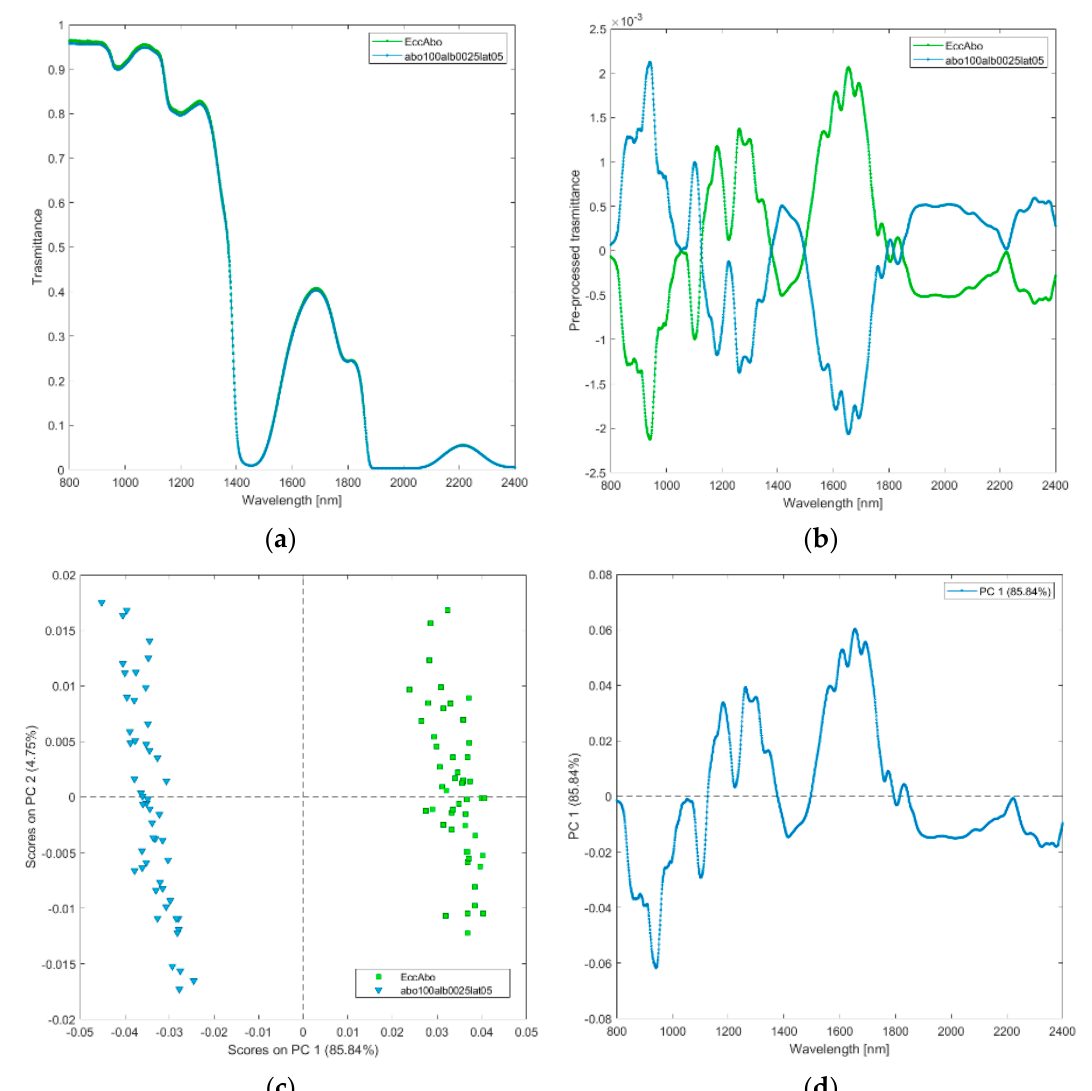
Figure 5. Average raw ( a ) and pre-processed ( b ) transmittance spectra for abobotulinum A toxin at standard clinical dilutions (abo100alb0025lat05), and its excipients (EccAbo). PC1 − PC2 score plot ( c ) and loading plot of PC1 ( d ) for abobotulinum A toxin at standard clinical dilutions (abo100alb0025lat05), and its excipients (EccAbo). (v) Solutions of incobotulinum A toxin (inco100alb1sac46), and its excipients (Ec- cinco1). The raw and pre-processed transmittance spectra of incobotulinum A toxin and its excipients are shown in Figure 6a,b. PCA scores plot and loadings plot are shown in Figure 6c,d. PC1 captured 81% of the total variance and discriminated incobotulinum A toxin from its excipients (Figure 6c). Incobotulinum A toxin scores are in the PC1